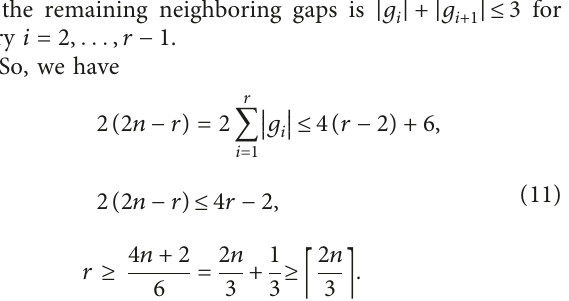
Figure 4 The metric dimension of friendship graph dim for n 2, computed by Mulyono and Wulandari in [31]. ≥